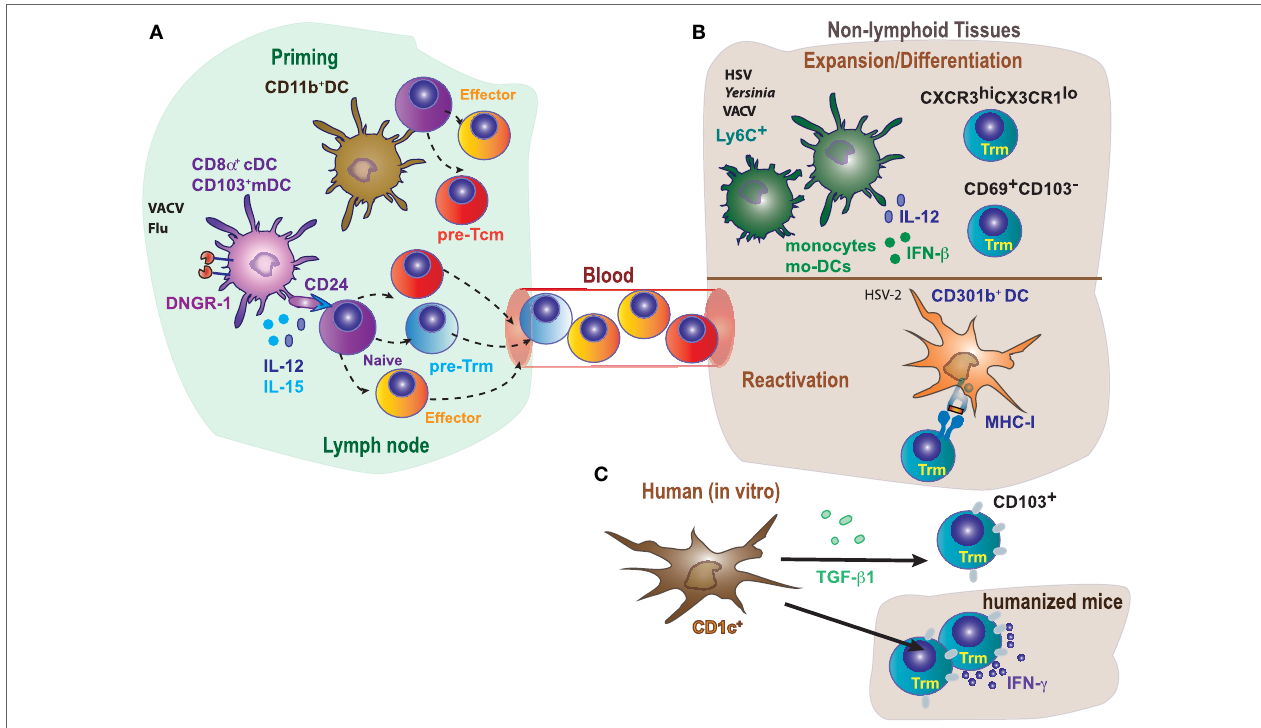
FiGURe 3 | Differential role of antigen-presenting cells in priming, expansion/differentiation, and reactivation of tissue-resident memory T cells. (A) In mice, optimal generation of Trm in response to VACV or Flu requires CD8 + T cells cross-priming by DNGR-1 + dendritic cells (cDC1, CD8 α + , and CD103 + ), while circulating memory T cells could be primed by both CD11b hi (cDC2) or cDC1. Naive T cells cross-primed by cDC1 receive CD24 co-stimulation, IL-15 and IL-12 specifically produced by this dendritic cell (DC) subset, contributing to the generation of committed Trm precursors. (B) Monocytes (Ly6C + ) and monocyte-derived DC (Mo-DCs) contribute to expansion of Trm in response to HSV or Yersinia by secretion of inflammatory cytokines, and also modulate the generation/differentiation of specific Trm subpopulations (CXCR3 hi CX3CR1 lo ; CD69 + CD103 − ). In addition, reactivation of Trm cells in response to HSV-2, requires MHC-I expression in CD301b + DC. (C) Notably, human CD1c + , but not CD141 + , induce CD103 expression on CD8 + T cells and their accumulation in the lung, in a process dependent on TGF- β